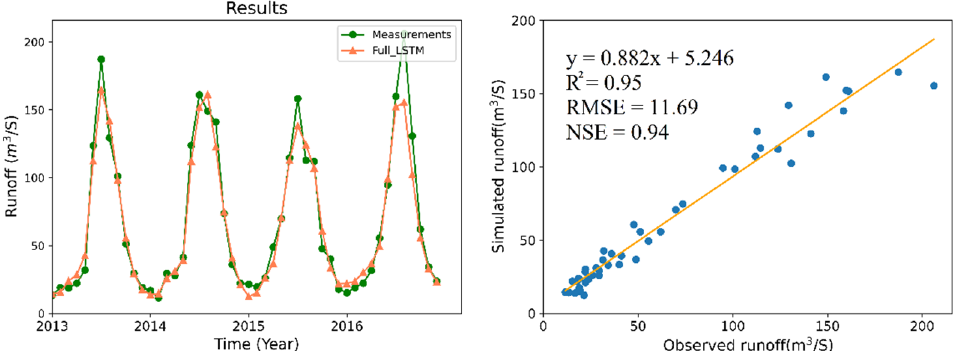
Figure 11. Runoff estimation obtained with L6 inputs. In the ( left ) half, the green and orange broken lines represent the observed runoff and estimated runoff, respectively. On the ( right ) side, the orange line indicates the linear regression trendline for the observed runoff and simulated runoff.